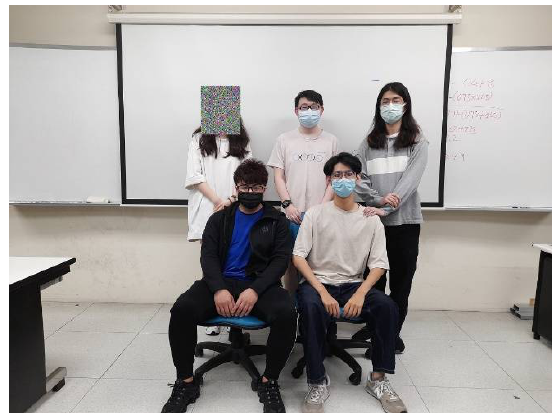
Figure 8. The result of Figure 7b. Table 2. The parameters of C j for Figure